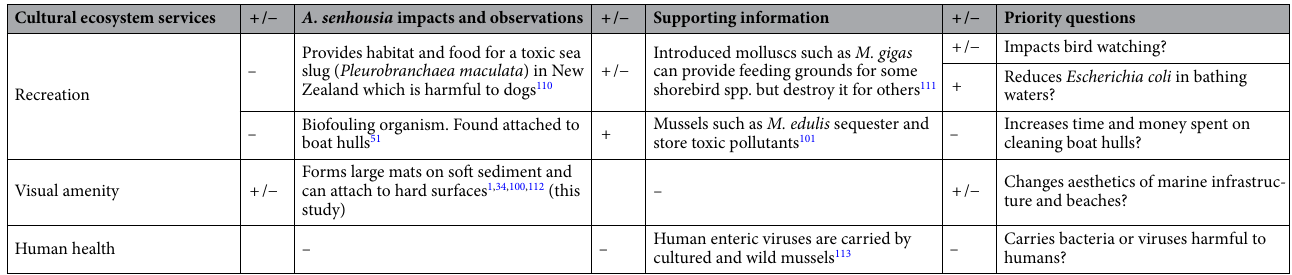
Table 5. A summary of the impacts of A. senhousia in relation to Cultural ecosystem services. ( +) denotes a potentially positive impact, (–) denotes a potentially negative impact. Priority questions are those that should be addressed by researchers to generate a full risk assessment and management